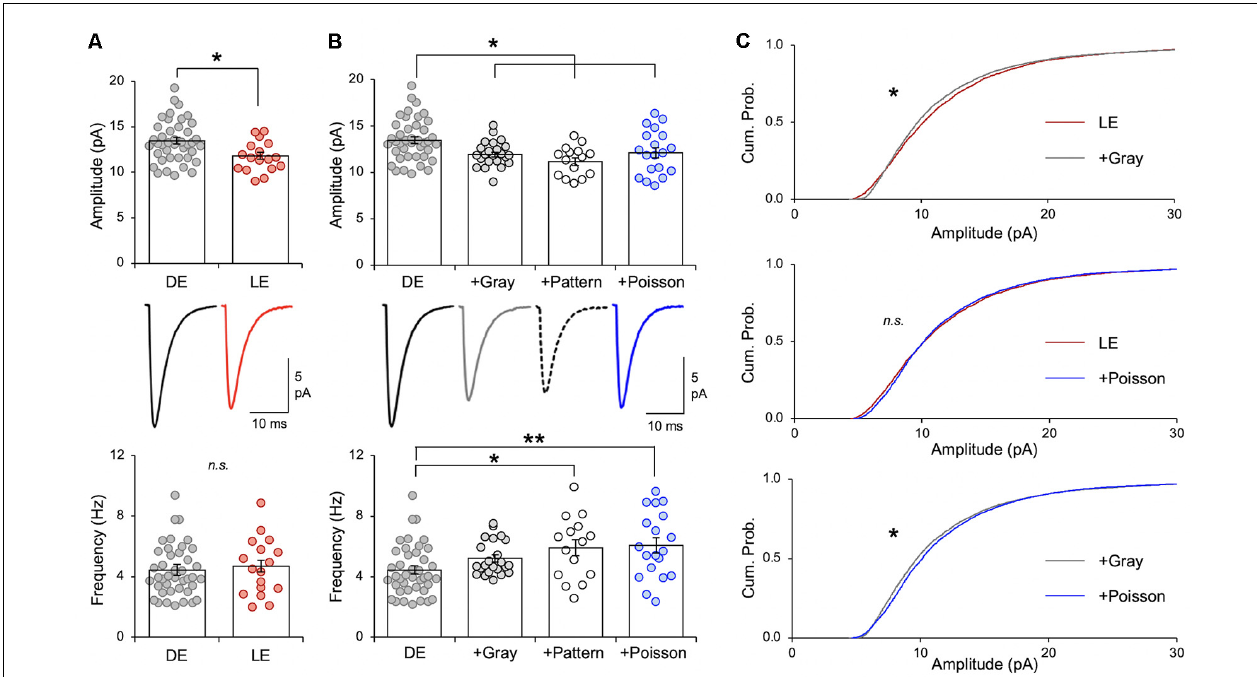
FIGURE 3 | Naturalistic spike patterns induce homeostatic synaptic depression. (A) LE decreases excitatory synaptic strength in mouse V1 L2/3 pyramidal neurons, as reported previously (Goel and Lee, 2007; Gao et al., 2010). Comparison of average mEPSC amplitude from V1 L2/3 pyramidal neurons following 2 days of DE and a subsequent 2 h of LE in P23–35 mice. Top: average mEPSC amplitude from individual cells are shown as circles and mean ± S.E.M. are shown as bars (DE = 13.46 ± 0.36 pA, n = 41, LE = 11.81 ± 0.40 pA, n = 17; unpaired t -test, t = 2.716, ** p = 0.0088). Middle: average mEPSC traces. Bottom: there was no change in average mEPSC frequency (DE median = 4.021 Hz, LE median = 4.592 Hz; Mann–Whitney test, U = 330, p = 0.761). (B) Top: comparison of average mEPSC amplitudes from different stimulation regimes. mEPSCs were recorded from the following groups: V1 slices from DE mice (DE), V1 slices from DE mice stimulated with in vivo spike patterns from exemplar cells of LE (+Gray; +Pattern), and V1 slices from DE mice stimulated with a Poisson random train (+Poisson). Average mEPSC amplitudes of individual cells are plotted as circles and mean ± S.E.M are shown as bars (DE: the same data shown in panel A are replotted here for comparison; DE+Gray = 11.93 ± 0.28 pA, n = 23; DE+Pattern = 11.18 ± 0.41 pA, n = 15; DE+Poisson = 12.11 ± 0.55 pA, n = 19; ANOVA, F = 5.138, p = 0.0025; Newman–Keuls multiple comparison test, * p < 0.05). Middle: average mEPSC traces. Bottom: comparison of average mEPSC frequency across groups (DE median = 4.021 Hz; DE+Gray = 4.753 Hz; DE+Pattern = 6.298 Hz; DE+Poisson = 5.695 Hz; Kruskal—Wallis statistic = 13.47, p = 0.0037; Dunn’s multiple comparison test, * p < 0.05, ** p < 0.01). (C) Top: cumulative probability of mEPSC amplitudes of LE (red line) and +Gray (gray line) group. There is a significant difference between the two groups (Kolmogorov–Smirnov test: * p < 0.0001). Middle: cumulative probability of mEPSC amplitudes of LE (red line) and +Poisson (blue line) group. There was no statistical difference in the distribution (n. s.). Bottom: cumulative probability of mEPSC amplitudes of +Gray (gray line) and +Poisson